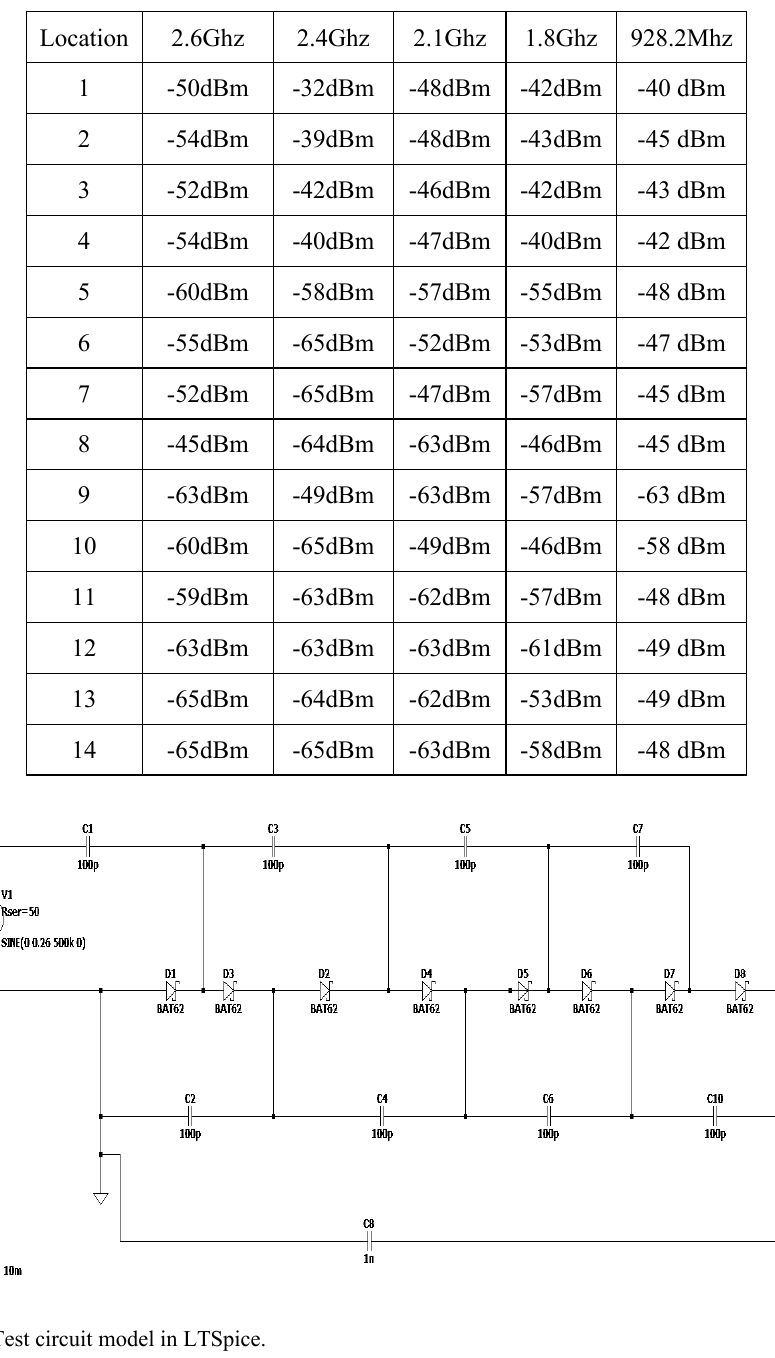
Table 2. Available power measurements.